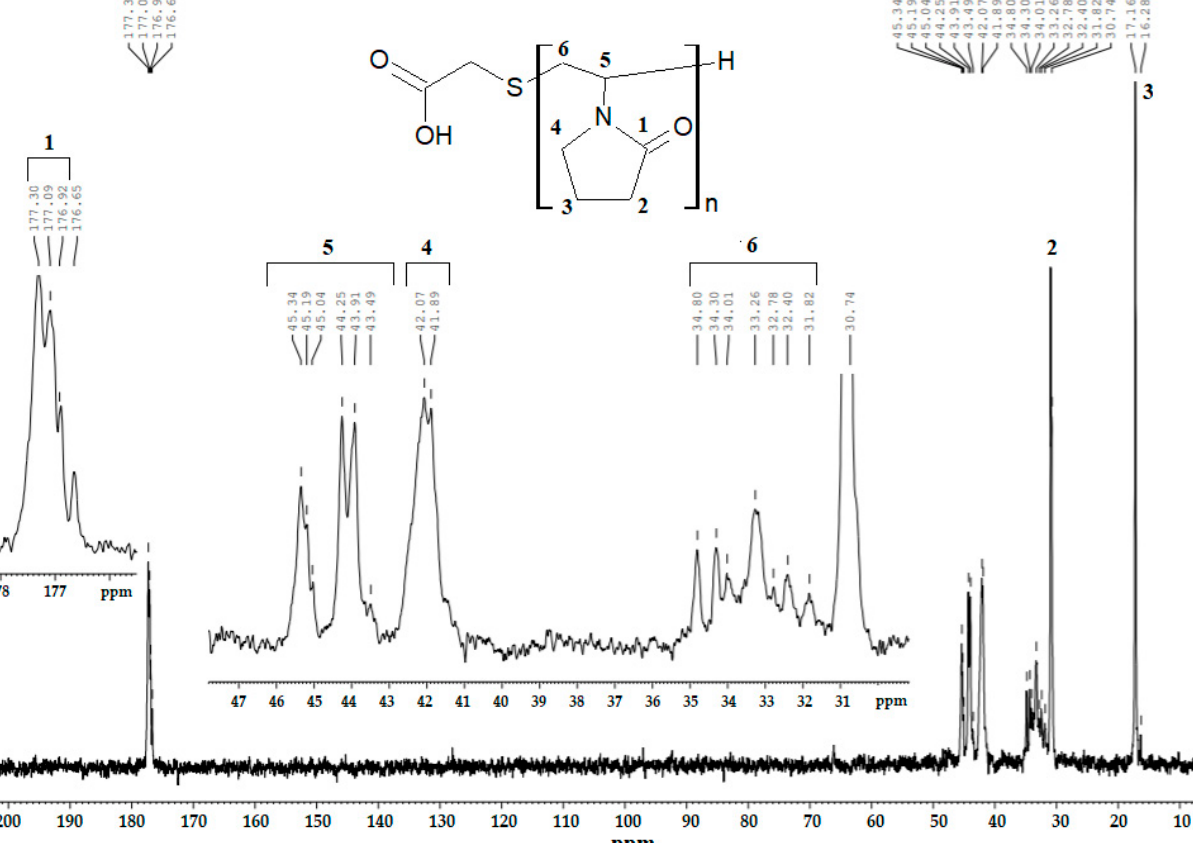
Figure 7. 13 C NMR spectrum (in D 2 O solution) of the telomer of N-vinyl-2-pyrrolidone obtained in the presence of sulfanylethanoic acid.